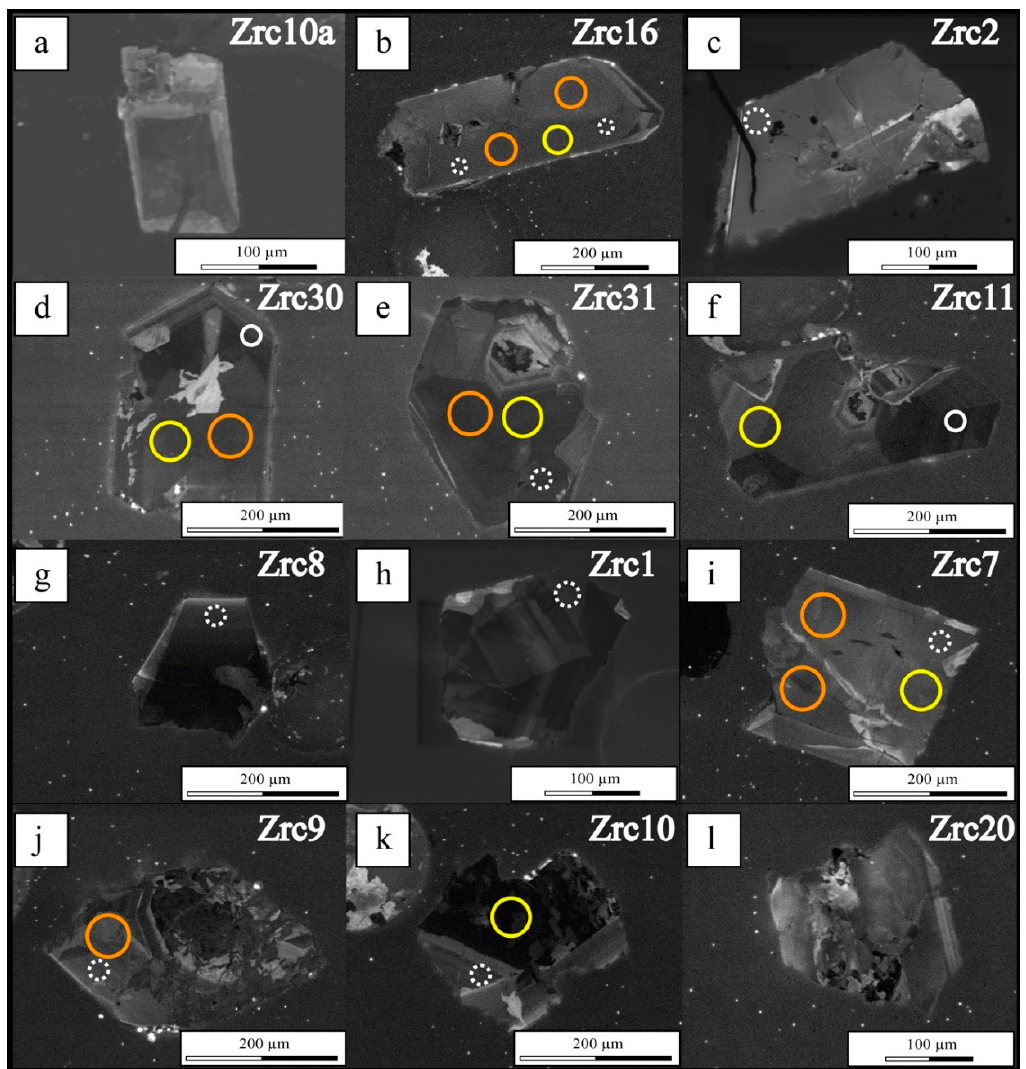
Figure 6. ( a – l ): SEM-CL image of zircon grains for sample SB09. The spot analyses are reported as circles: White dotted and solid circles refer to U–Pb concordant and discordant data, respectively; yellow and orange circles refer to trace element and Lu–Hf spot analyses.